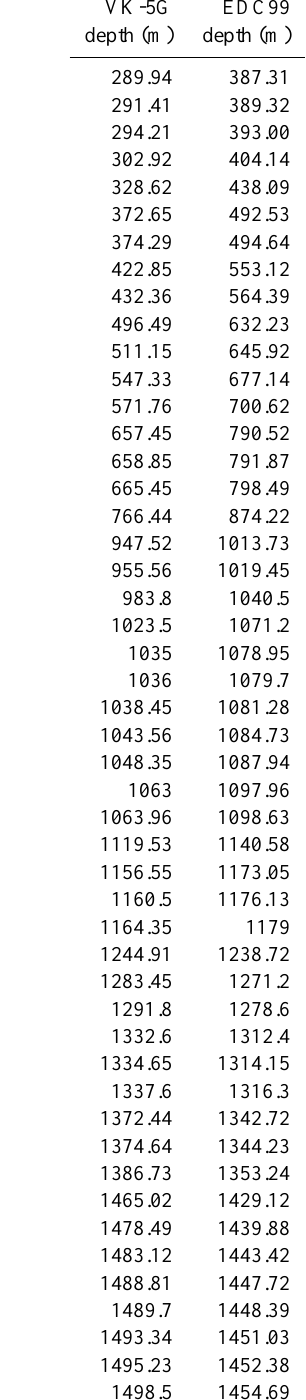
Table 4. List of volcanic tie points between the EPICA Dome C EDC99 and Vostok 5G ice